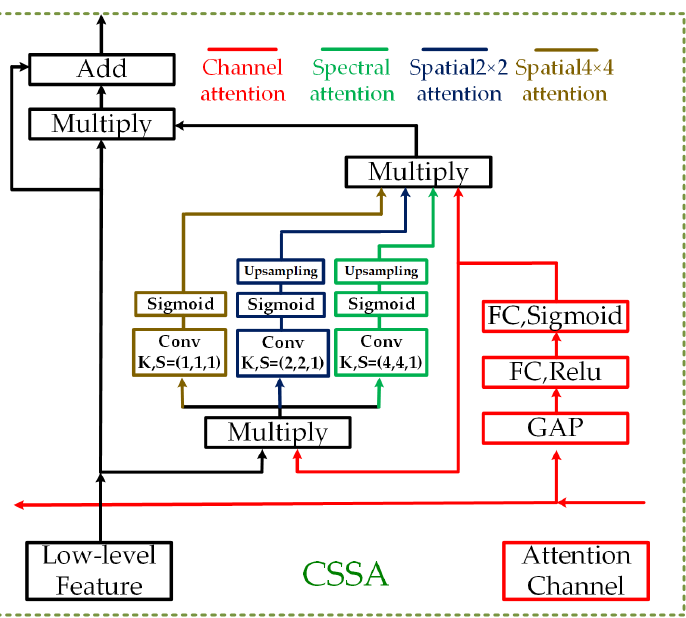
Figure 5. The triple-attention module, involving in channel-, spectral- and spatial- attention (CSSA). GAP, FC, K, S represents global average pooling, the fully connected layer, the kernel size and the stride, respectively. The triple-attention module(CSSA) has two inputs: (1) the feature maps at the highest level of the preceding subnetwork, and (2) the corresponding low-level feature maps of the same stage. The total weight is generated by aggregating the three types of attention